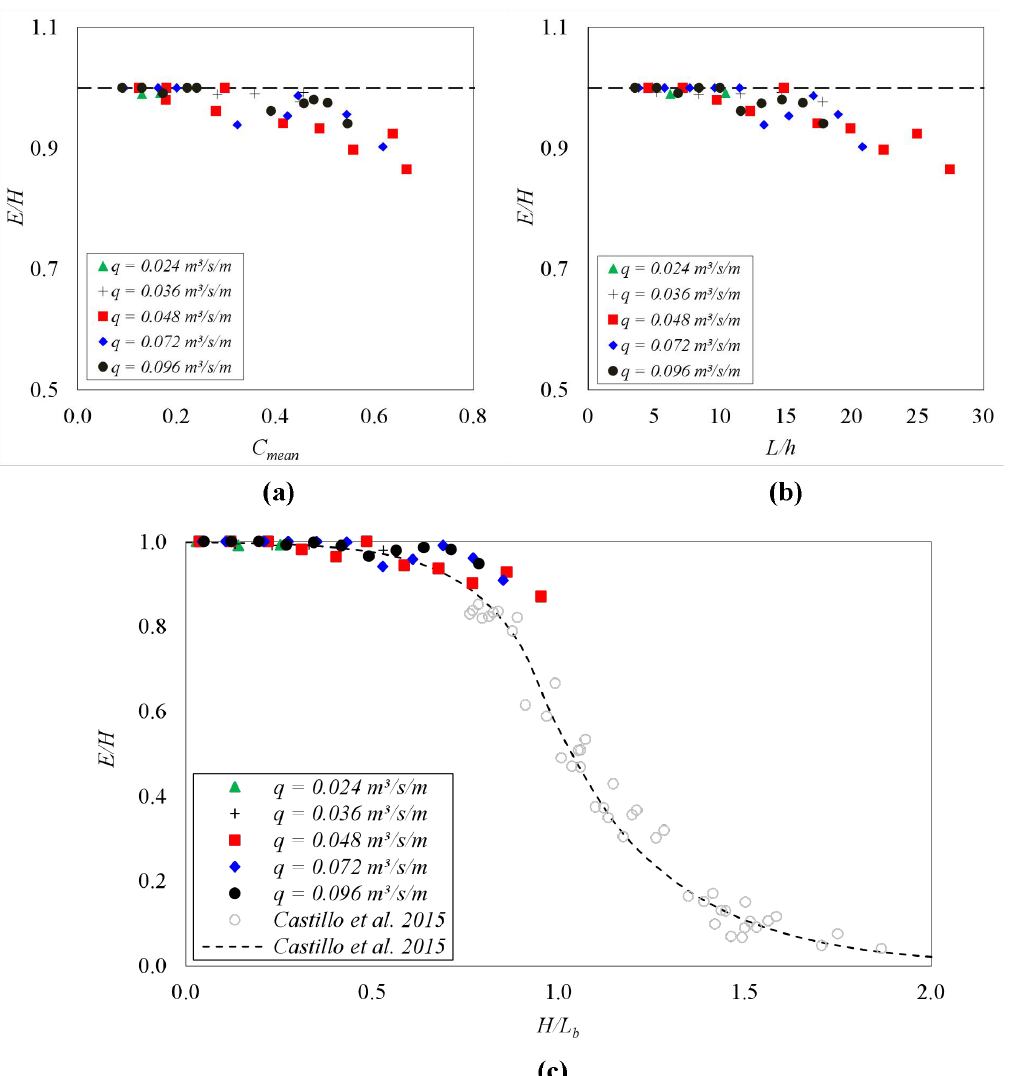
Figure 12. Dimensionless energy E/H : ( a ) as a function of Cmean ; ( b ) as a function of the L/h ratio; ( c ) as a function of the H/L b ratio.